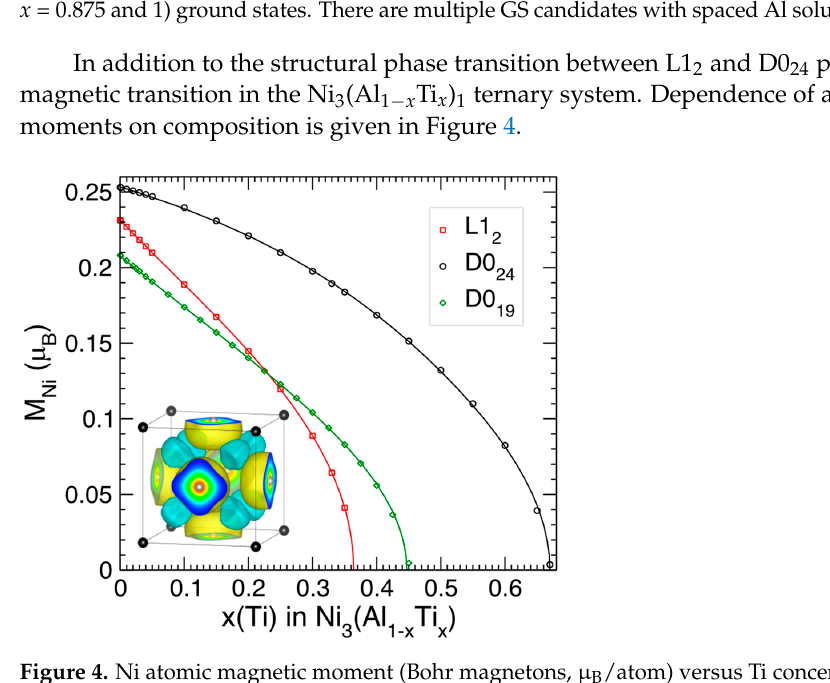
Figure 5. Electronic density of states (states/eV ∙ spin ∙ atom) of magnetic Ni 3 Al ( a ) and non-magnetic Ni 3 Ti ( b ) in L1 2 (red) and D0 24 (black) phases is compared to that of the L1 2 -based GS at x = 1/4 and 1/2 ( c ) and D0 24 -based GS at x = 7/8, 11/12, and 23/24 ( d ). 2. Methods and Materials 2.1. Theory Physically different systems can be described by similar mathematical equations. Hamiltonian formalisms are equivalent for a magnetic system composed of interacting particles with spins (moments with a quantized projection on the chosen axis) and for an alloy with a variable composition on each site, occupied by one of the available chemical elements. On an occupied site an atom can be displaced from the ideal crystallographic position [12]; a vacancy can be treated as another atomic type with zero nuclear charge. A magnetic quantum system can be described in terms of the spin variables s i . For spins s = ½ (here we omit the reduced Plank constant ℏ ), on each site i there are only 2 possible values of 𝑠 (cid:3036) = (cid:3399) (cid:3117) (cid:3118) , corresponding to either up or down spin orientations. The same spin- like variables s i can describe occupation of each site i in a binary alloy, which is composed of only 2 chemical elements (for example, Al and Ti). One can extend this formalism to